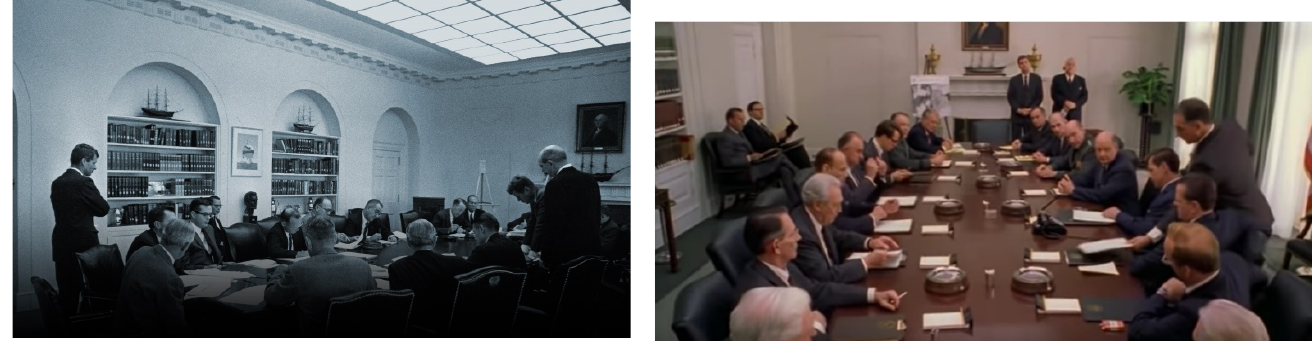
Figure 5 Actual